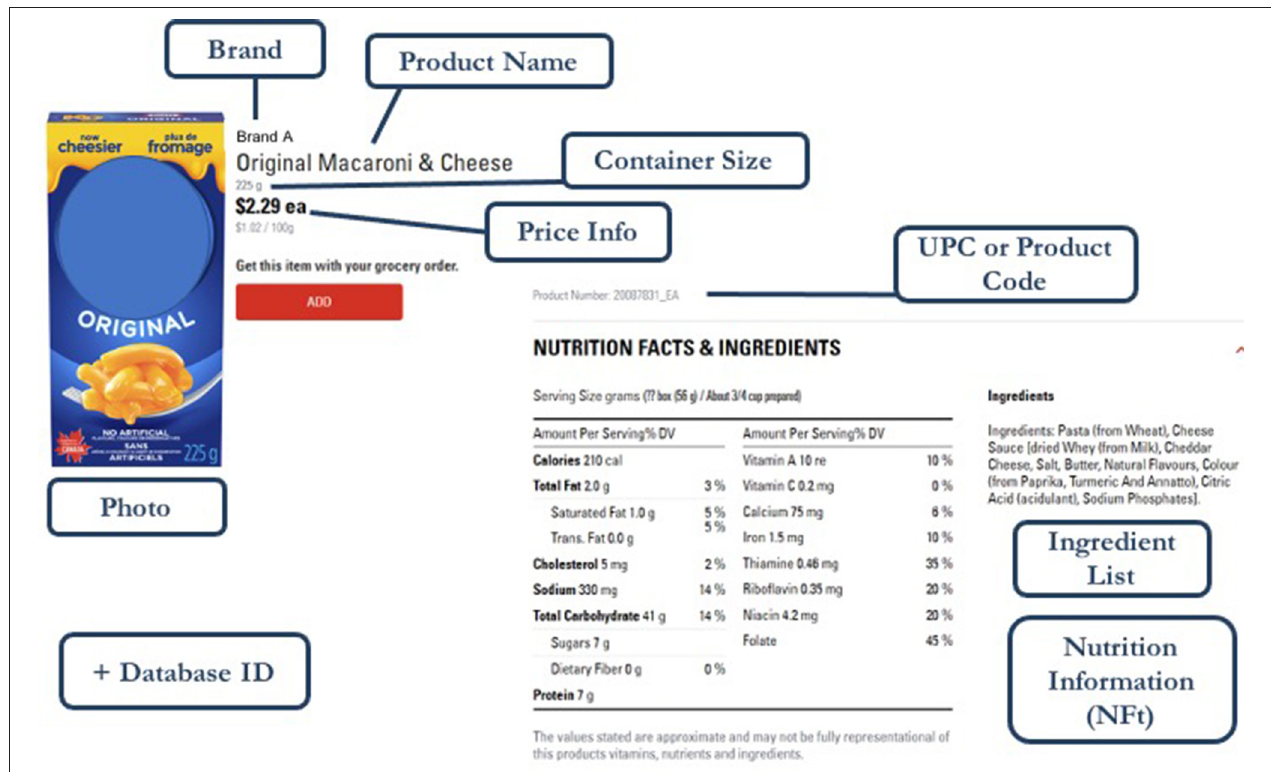
FIGURE 2 | Example of the web-scraped information captured from the website of a major Canadian grocery retailer.